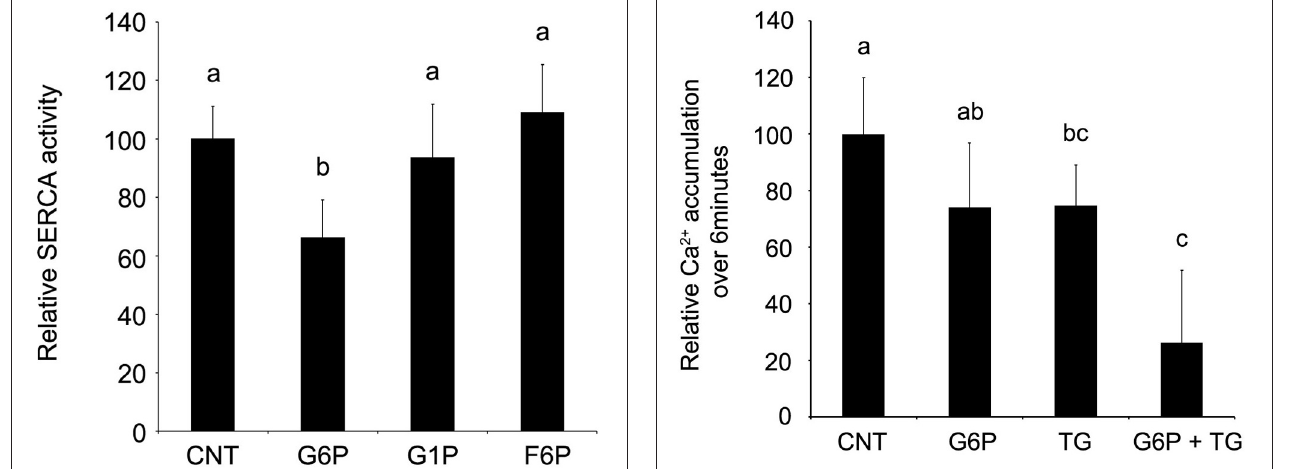
FIGURE 5 | Glucose-6-phosphate reduces microsomal SERCA hydrolytic activity, as quantified by decreased release of inorganic phosphate in comparison to other hexose phosphates tested. Glucose-6-phosphate (10mM) significantly reduced ( p < 0 . 05) the release of inorganic phosphate from brain ER microsomes after 6min incubation. Neither glucose-1-phosphate (10mM) nor fructose-6-phosphate (10mM) altered phosphate release ( p > 0 . 05) in comparison to control. Data are means ± SEM for n = 7. ab Means with differing superscripts are significantly different, p < 0 . 05, while means that share superscripts are not significantly different.